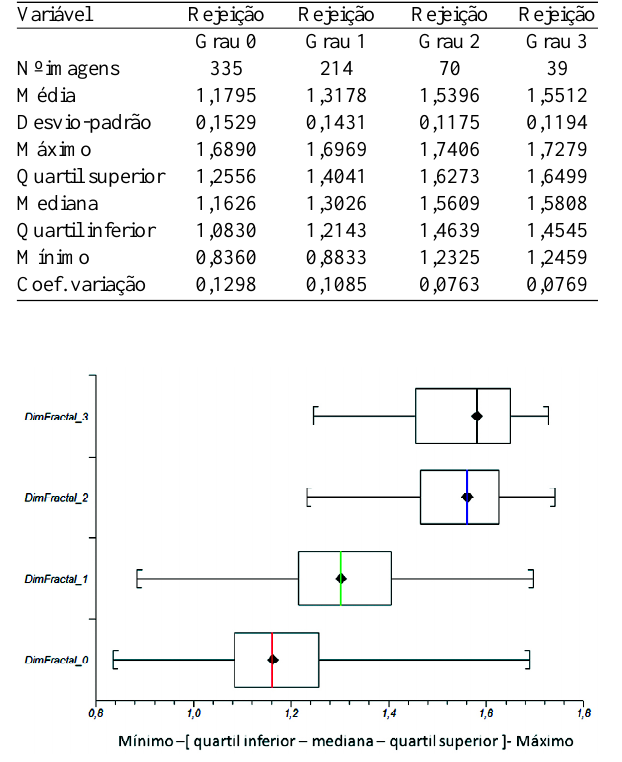
Fig. 1 - Gráfico Box-plot (valor mínimo, quartil inferior, mediana, quartil superior, valor máximo) da dimensão fractal das lâminas de biopsia endomiocárdica, nos diferentes graus de rejeição cardíaca